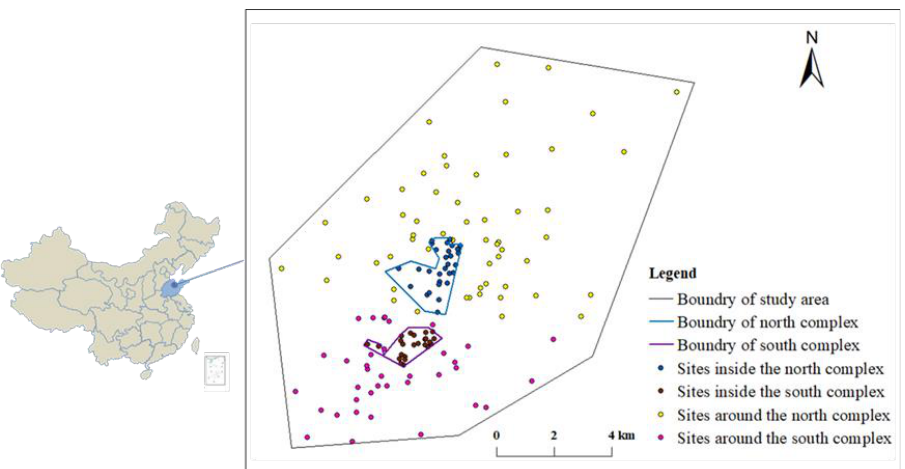
Figure 1. Soil sampling sites of the study area.